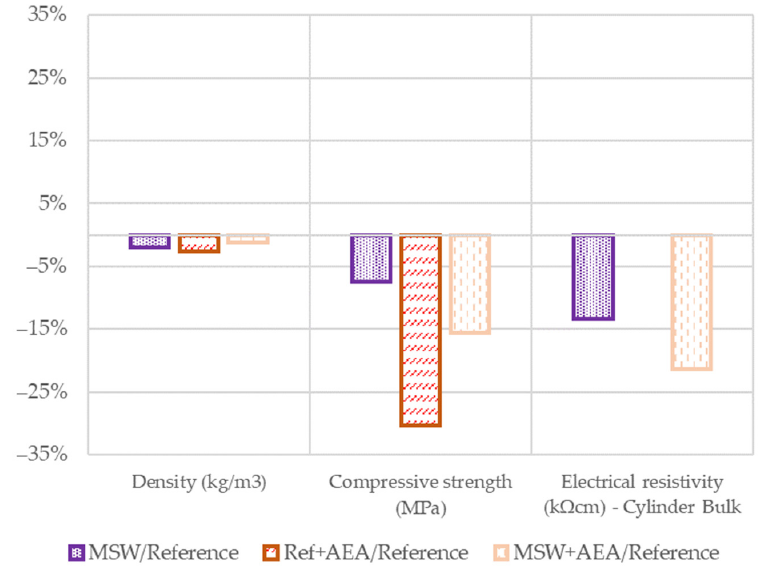
Figure 4. Relative results in 28 days.